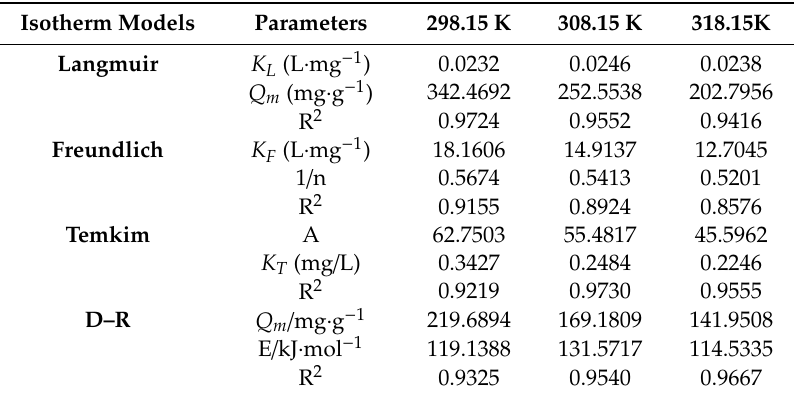
Table 6. Fitting parameters of isotherm fitting for BPA adsorption onto